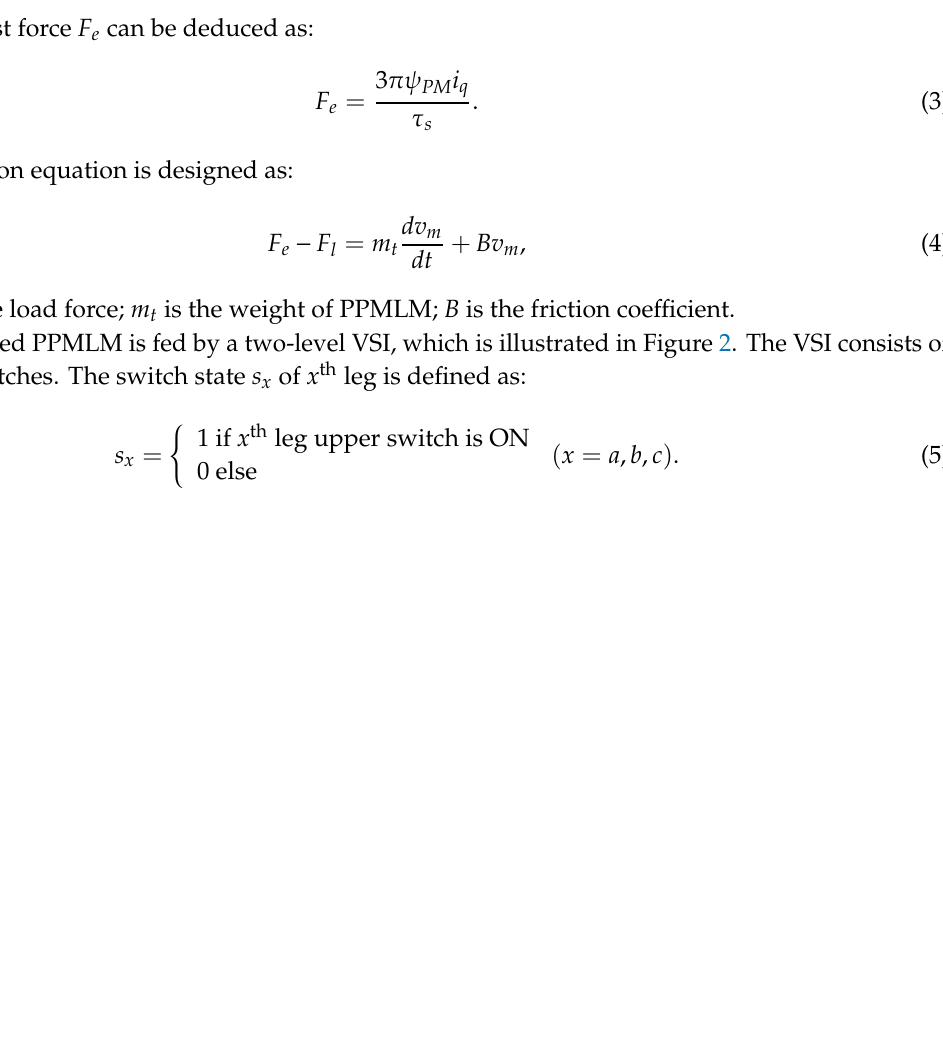
Figure 1. Structure of the studied primary permanent-magnet linear motor (PPMLM).